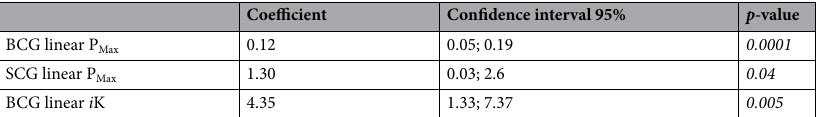
Table 6. Estimation of LVEF. Generalized linear model. Variables taken into the model were SCG linear P Max , BCG linear P Max , SCG rotational P Max , BCG rotational P Max , SCG linear i K, BCG linear i K, SCG rotational i K, BCG rotational i K. Outcome: LVEF. P Max maximal power, iK integral of kinetic energy,